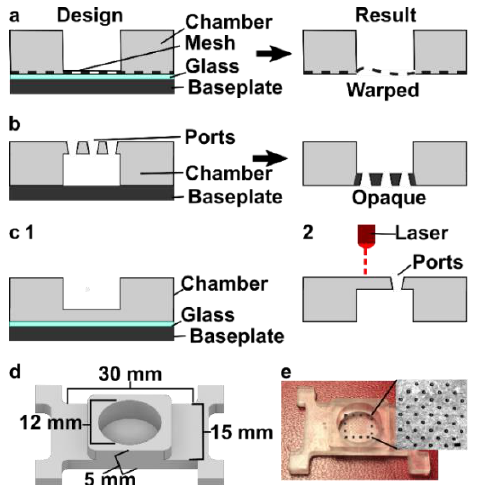
Figure 4. Optimization of the fabrication strategy for a 3D printed chamber with a microporous bottom. Three fabrication strategies were tested: ( a ) incorporating a mesh at the bottom of the device by adhering it to the glass-covered base plate during printing, ( b ) directly printing ports, and ( c ) laser etching the ports after printing. ( d , e ) The optimized design of the chamber component shown as an AutoCAD inventor drawing and the 3D printed and laser-etched piece. Inset: Micrograph of the ports etched into the chamber. Scale bar 0.5